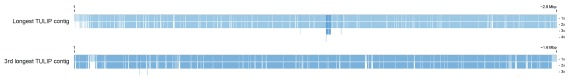
Tablet visualization of Spades hybrid contigs aligned to TULIP contigs.The Spades hybrid contigs aligned against longest TULIP contig (~2.8 Mbp) and the third longest TULIP contig (~1.6 Mbp). White horizontal lines indicate coverage boundaries and show that most regions on the TULIP contigs are covered twice. Alignment gaps come from heavily fragmented Spades hybrid contigs that are aligned on contiguous TULIP contigs. Visualization is based on coverage overview settings in Tablet.